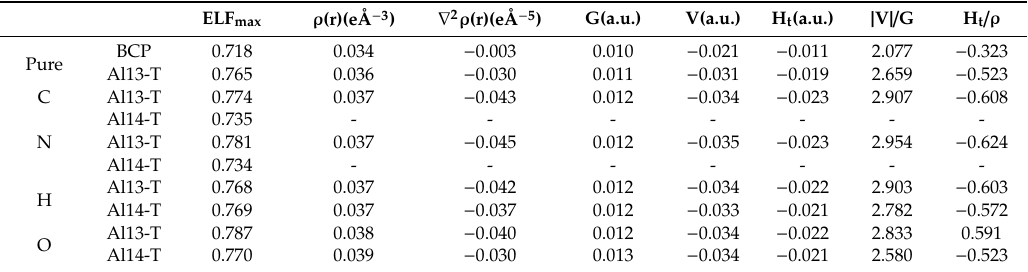
Table 1. Properties of ELF and Quantum Theory of Atoms in Molecules (QTAIM) at non-nuclear maxima (NNM) of the three-center region and bond critical points (BCP) on Layer7 at 0 shear displacement under pure and interstitial atom environment.